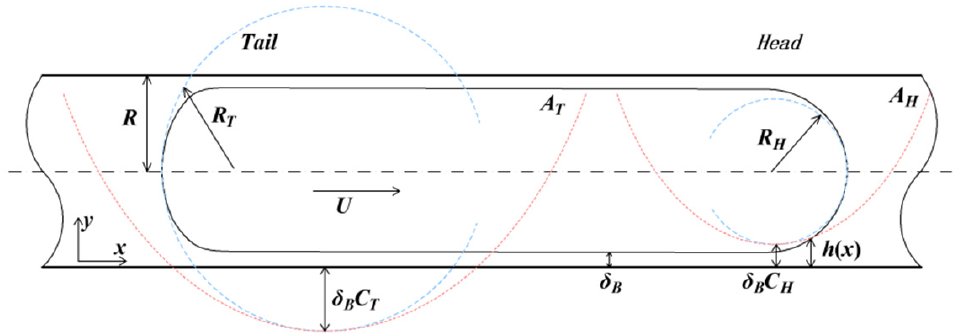
Figure 4. Schematic diagram of a slug bubble moving with velocity U B in a circular